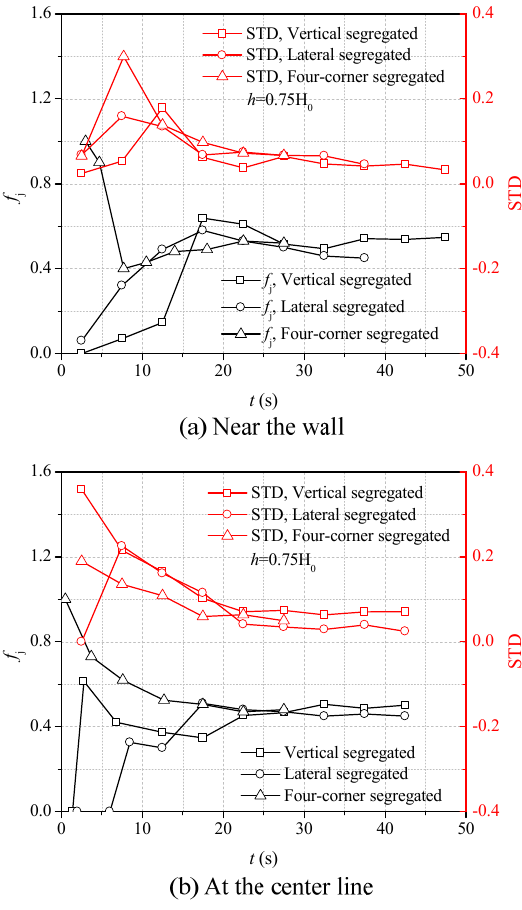
Figure 8. Variations of micro mixing ratio and its standard deviation with time at different lateral positions when three static beds are used. ( a ) Near the wall. ( b ) At the center